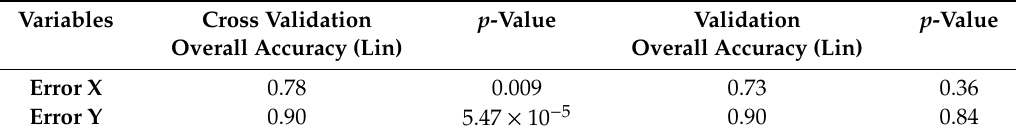
Table 4. Cross validation and validation results with the 50 GCP dataset.